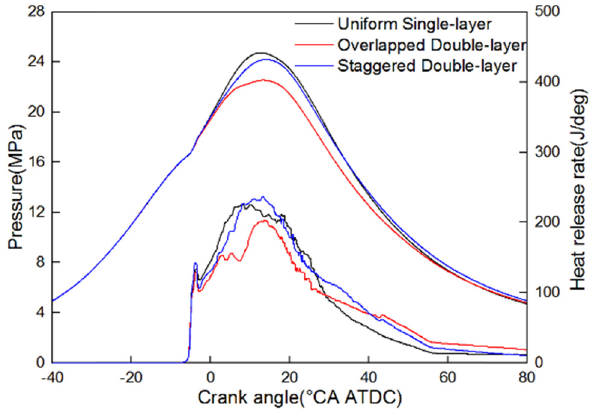
Figure 19: In - cylinder pressure and heat release rate traces under di ff erent arrangements of nozzle holes.